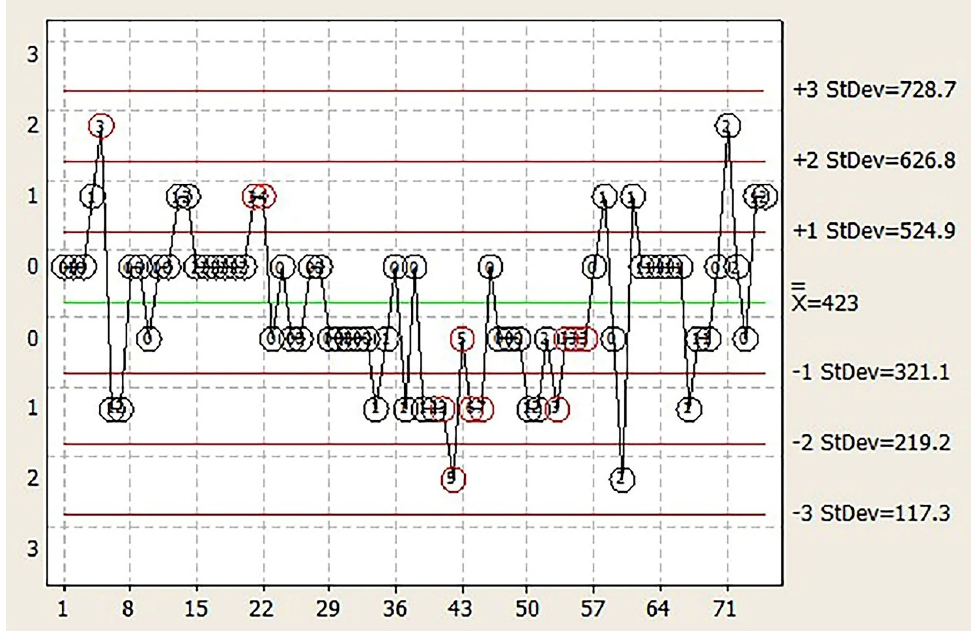
Figure 6. Zone chart for data series (deviation of the standard deviation about the